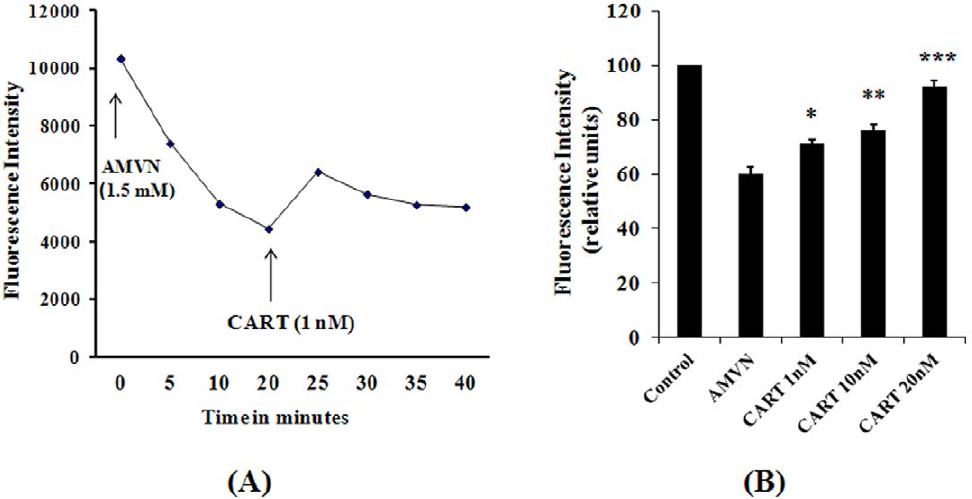
Figure 5. Radical scavenging role of CART. ( A ) Effects of CART on AMVN-induced fluorescence decay in mitochondria isolated from human SHSY cells. AMVN 1.5 mM was added to the reaction medium (0.2 ml) containing mitochondria 50 m g, cis PA 12 m M in 0.1 M KCl and phosphate buffer (50 mM, pH 7.4 at 40 u C). CART (1 nM) was added 20 min later. The fluorescence intensity was monitored by using a BIO-TEK spectrofluorometer. ( B ) Radical scavenging activity of CART in mitochondria isolated from HEK293 cells. The reaction containing 50 m g mitochondria, cisPA 6 m M, CART peptides and AMVM 2 mM in 0.1 M KCI and phosphate buffer was performed at 40 u C for 20 min, and the fluorescence intensity was measured after continued incubation at RT for 90 min. *, P , 0.05; **, P , 0.01; ***, P , 0.001, comparing with AMVM group.